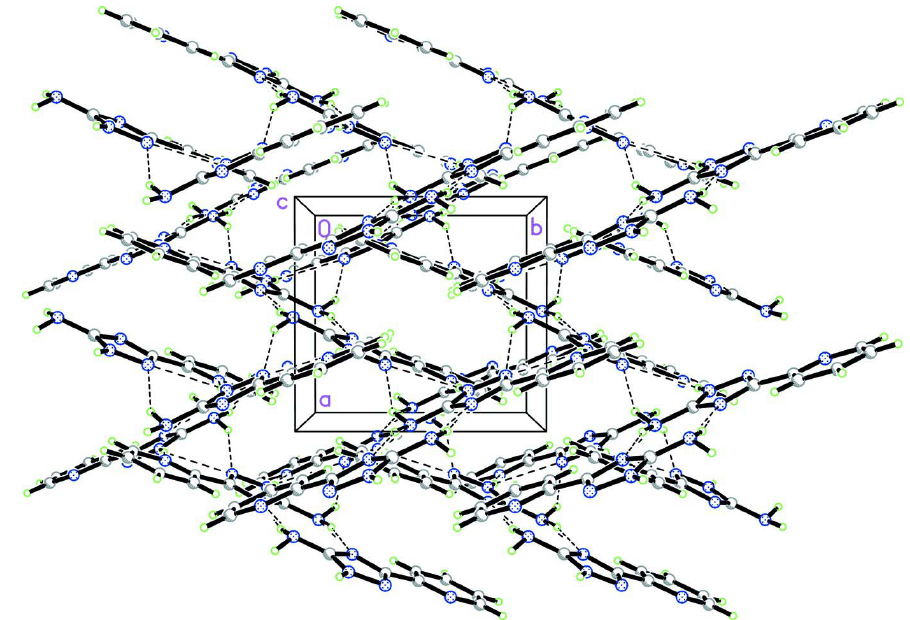
Molecular packing of the title compound, viewed along the c